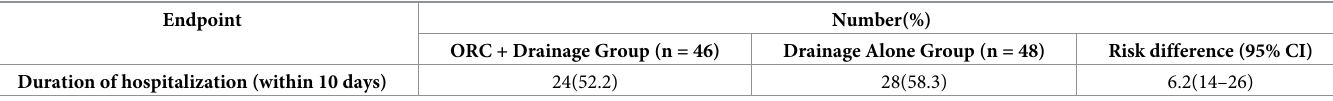
Table 3. Both absolute and relative effect sizes between the two groups in patients who discharged within